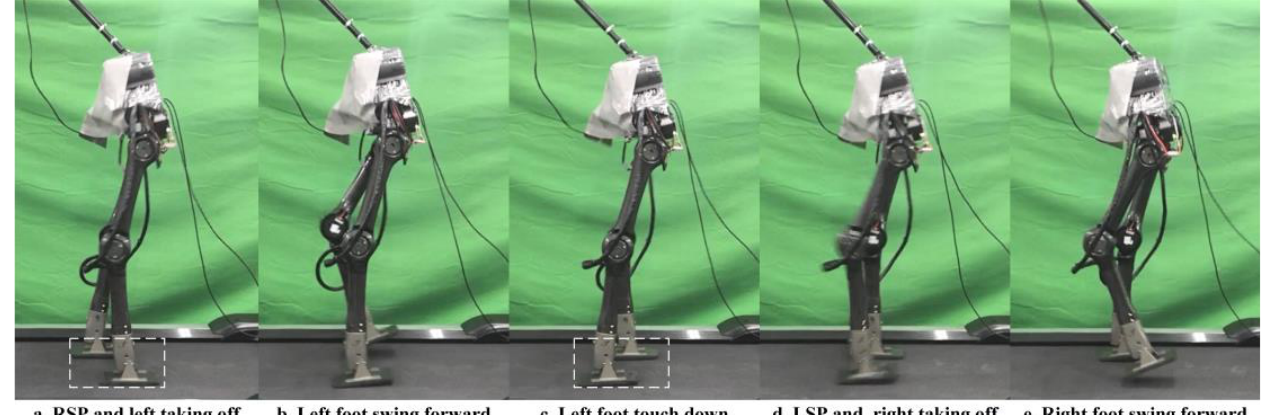
Figure 10. Five key frames of symmetrical walking experiment.